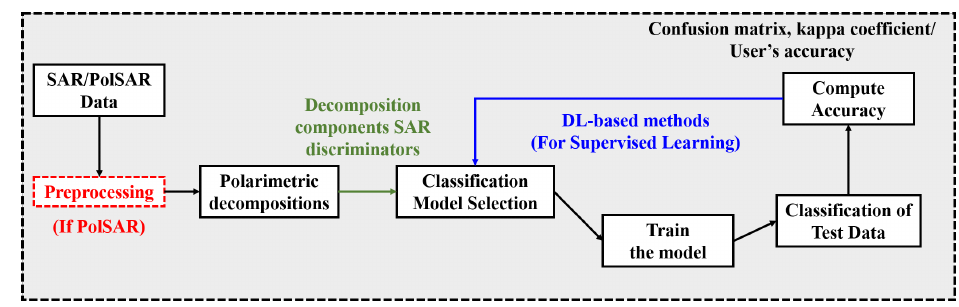
Figure 23. General classification scenario of SAR images.